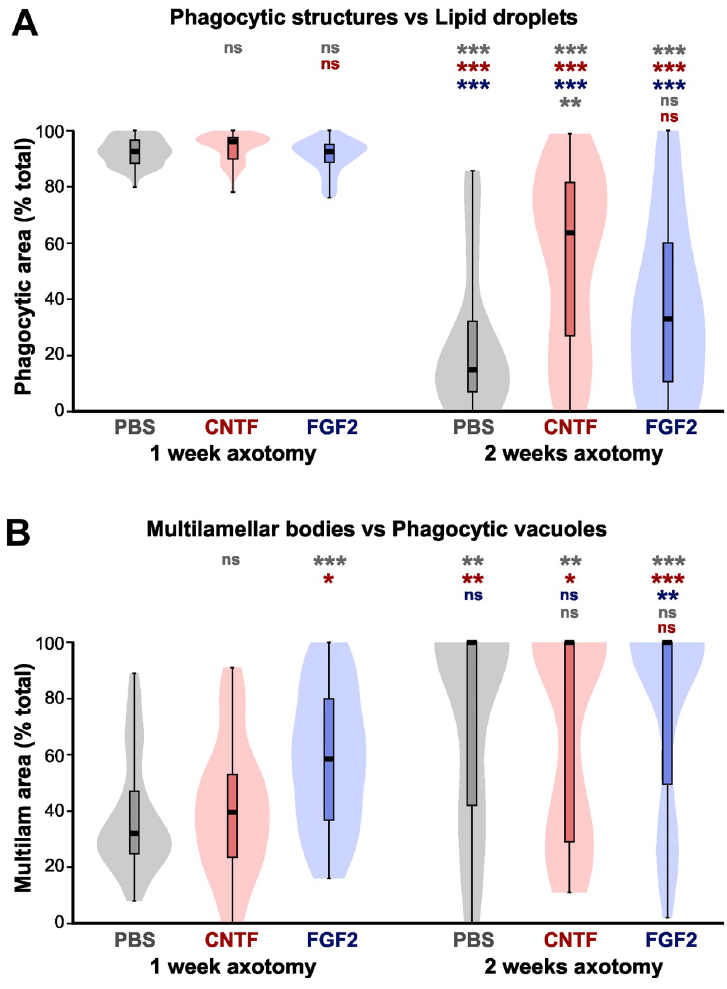
Fig 8. CNTF treatment prolongs phagocytic activity. Kernel density (“violin”) plots with superimposed box-whisker plots of organelle areas, expressed as a percentage of the total organelle area. Asterisks or “ns” above each column indicate the significance when compared to PBS (rows 1 and 4, gray), CNTF (rows 2 and 5, red), or FGF2 (row 3, blue) with ANOVA and post-hoc Mann-Whitney comparisons using Bonferroni p-correction ( � P < 0.05, �� P < 0.01, ��� P < 0.001). (A) Comparison of relative areas occupied by “phagocytic organelles” (vacuoles + multilamellar bodies) versus lipid inclusions. At one week, the majority of cells are predominantly occupied by “phagocytic organelles” as opposed to lipid inclusions. At two weeks most cells are occupied predominantly by lipid inclusions in PBS controls, but there is a significant increase in phagocytic cells with CNTF treatment. N (cells) = 42, 42, 36, 24, 41, 43. (B) Comparison of relative areas occupied by multilamellar bodies versus phagocytic vacuoles (combined as “phagocytic organelles” in Fig 8A). At one week after FGF2 treatment, there is a significant increase in the median area occupied by multilamellar bodies. At two weeks most cells are occupied by multilamellar bodies, although smaller populations remain with phagocytic vacuoles. N (cells) = 42, 42, 36, 19, 39, 34.